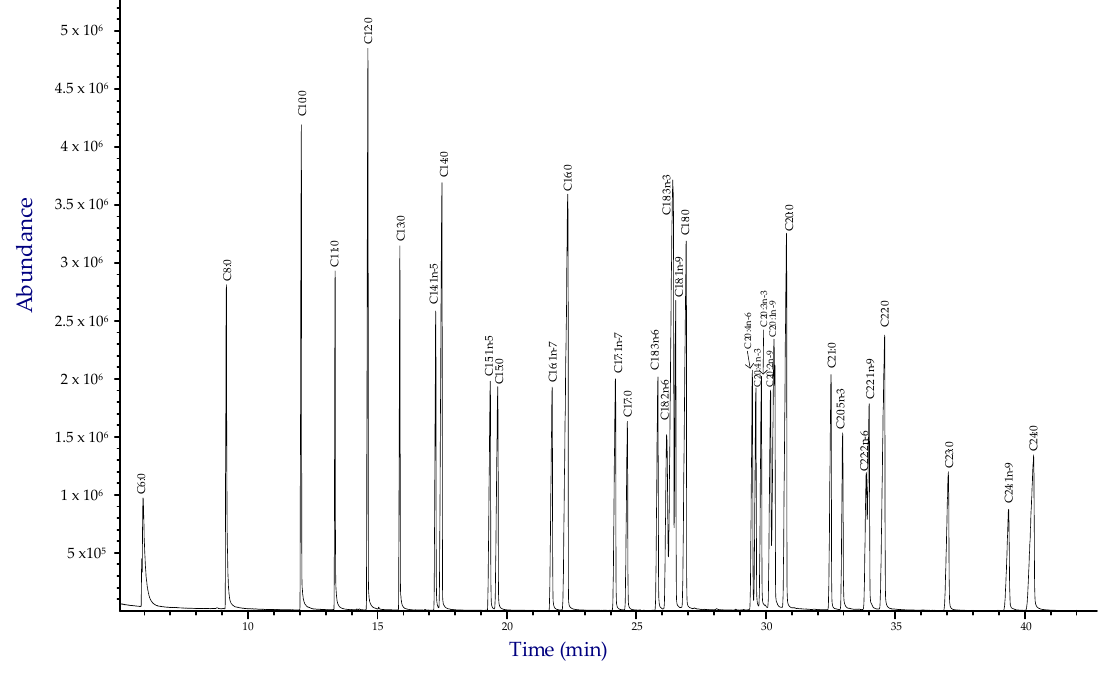
Figure 2. Total ion chromatogram (TIC) of a standard mixture of fatty acid methyl esters (FAMEs) obtained with the optimized method. Table1. Performancedataoftheoptimizedgaschromatography-massspectrometry(GC-MS)separation and quantification